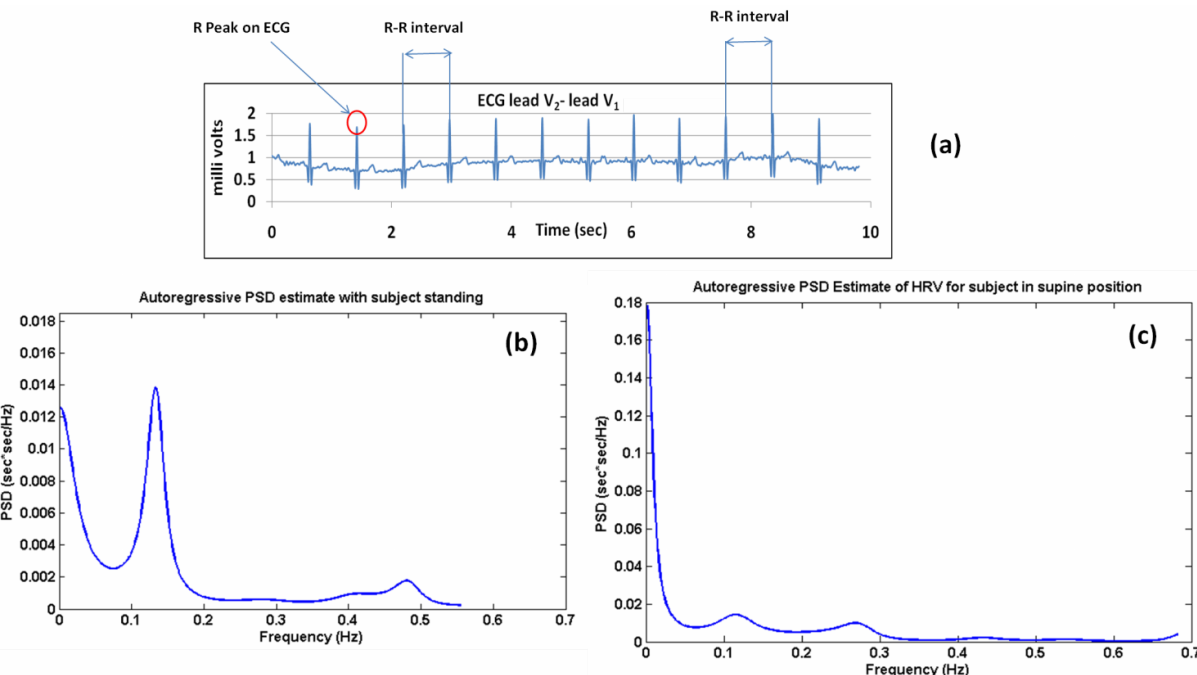
Figure 5. ( a ) R-R interval calculations from ECG; ( b ) plot of the autoregressive (AR) power spectrum density (PSD) computed from the RR interval (RRI) series for the standing case; ( c ) plot of the AR PSD computed from the RRI series for the supine